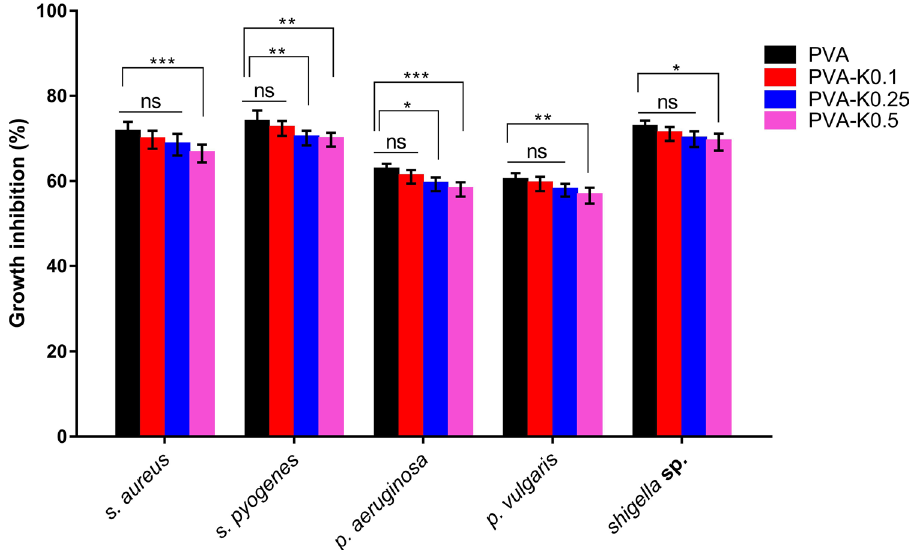
Figure 7. Antibacterial assays of PVA hydrogel membrane and PVA/Kaolin composite hydrogel membranes loaded with Pen-Strep against S. aureus , S. pyogenes , P. aeruginosa , P. vulgaris , and S higella sp. Data are presented as means ± SD (***p < 0.001, **p < 0.01, and *p < 0.05).